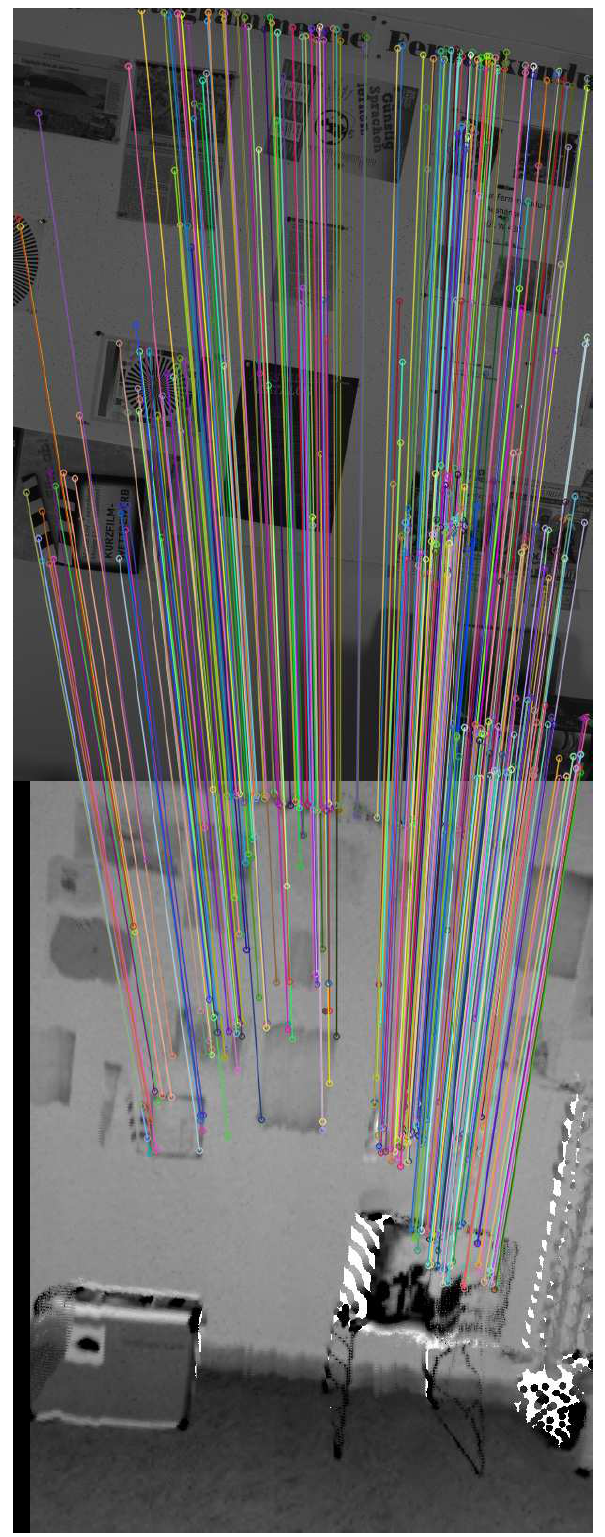
Figure 6. Matching result, the corresponding points are